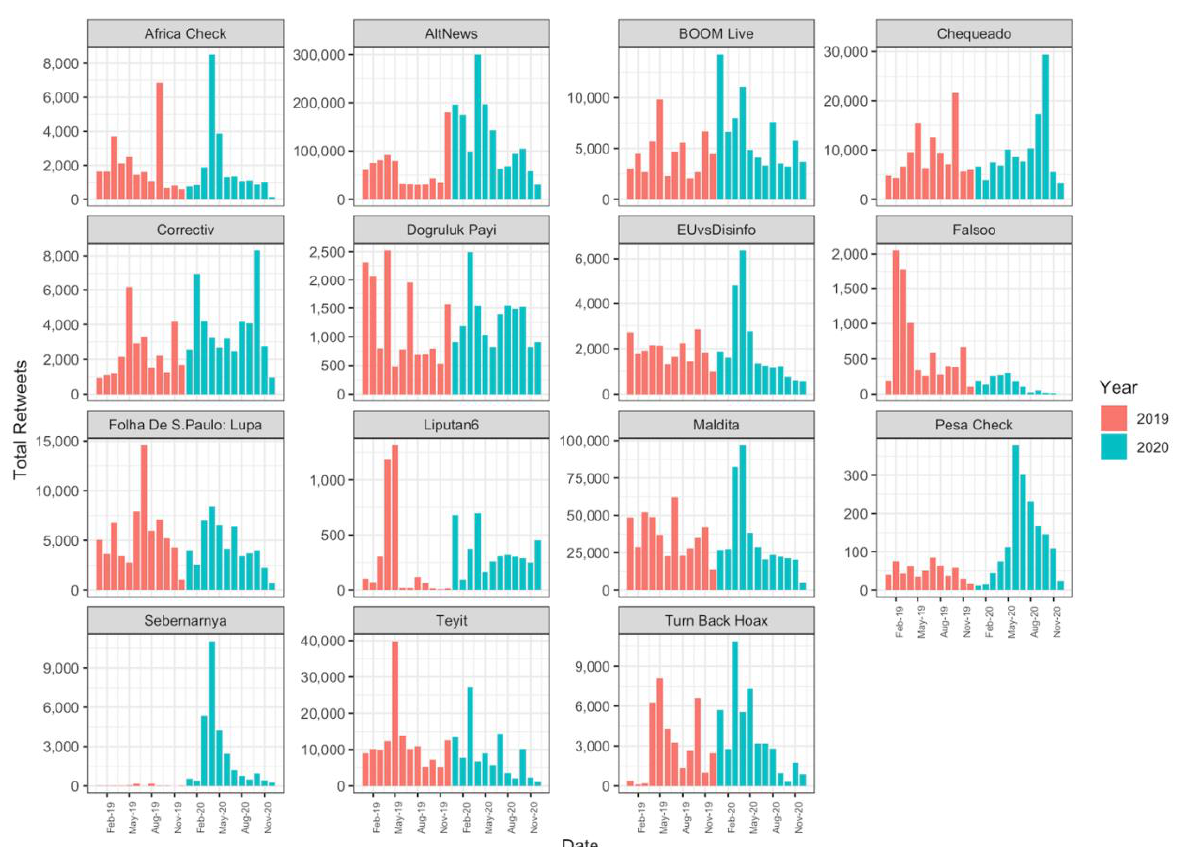
Figure B3. Distribution of user retweets of fact-checking content. The user engagement measured as retweets of fact-checking content in 2019 and 2020 is shown as a time series.